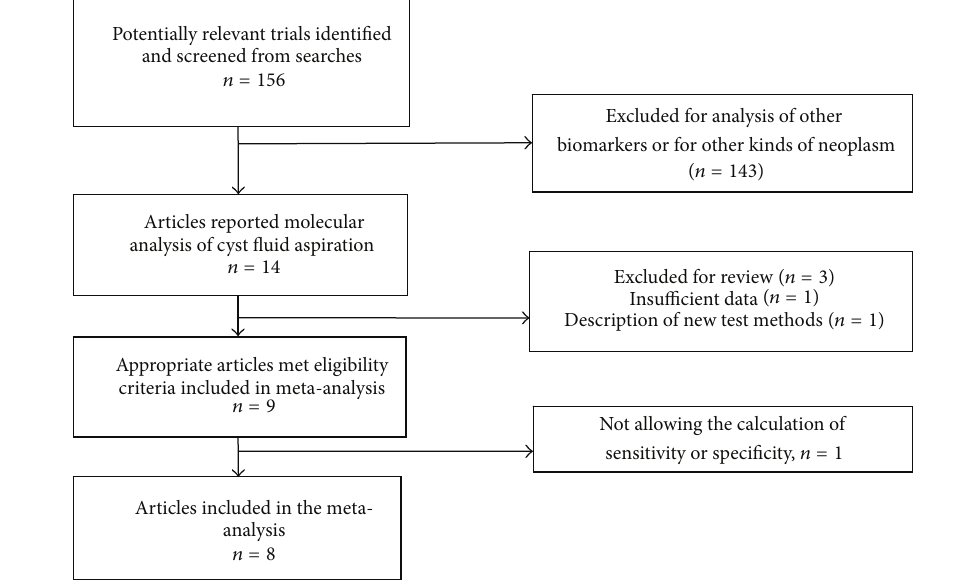
Figure 1: Study selection process. Table 1: Summary of included